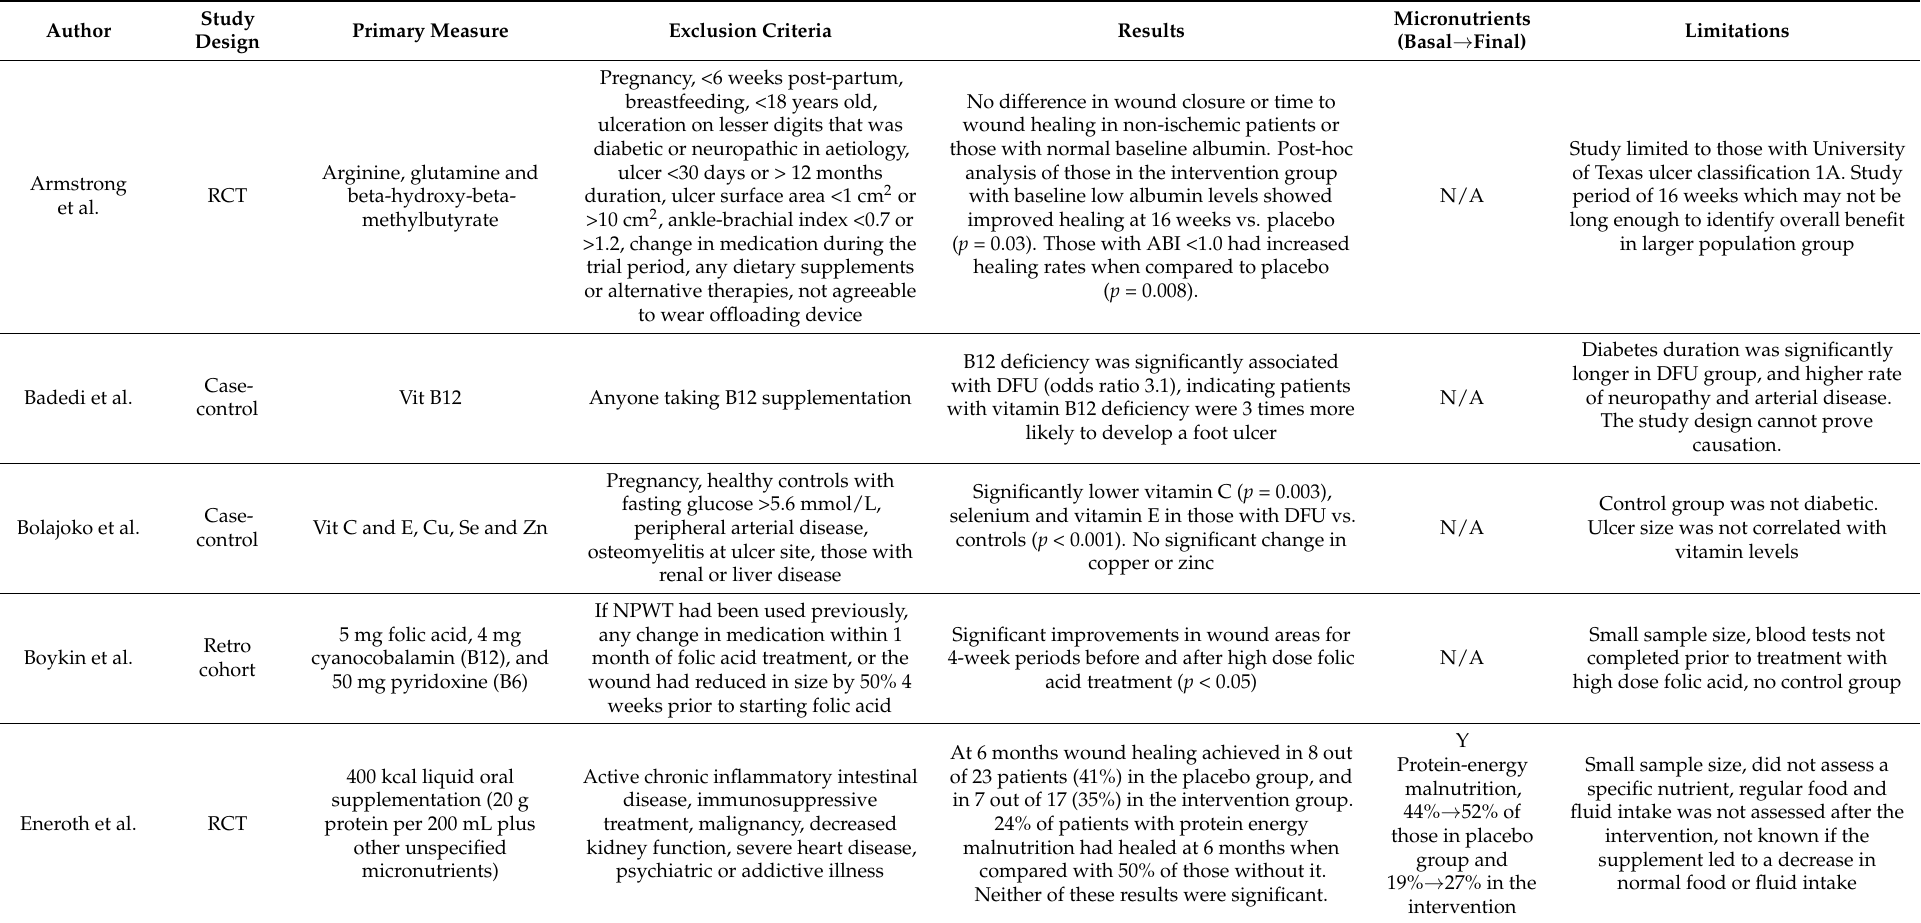
Table 4. Overview of study design and results of included articles other than the Aseni